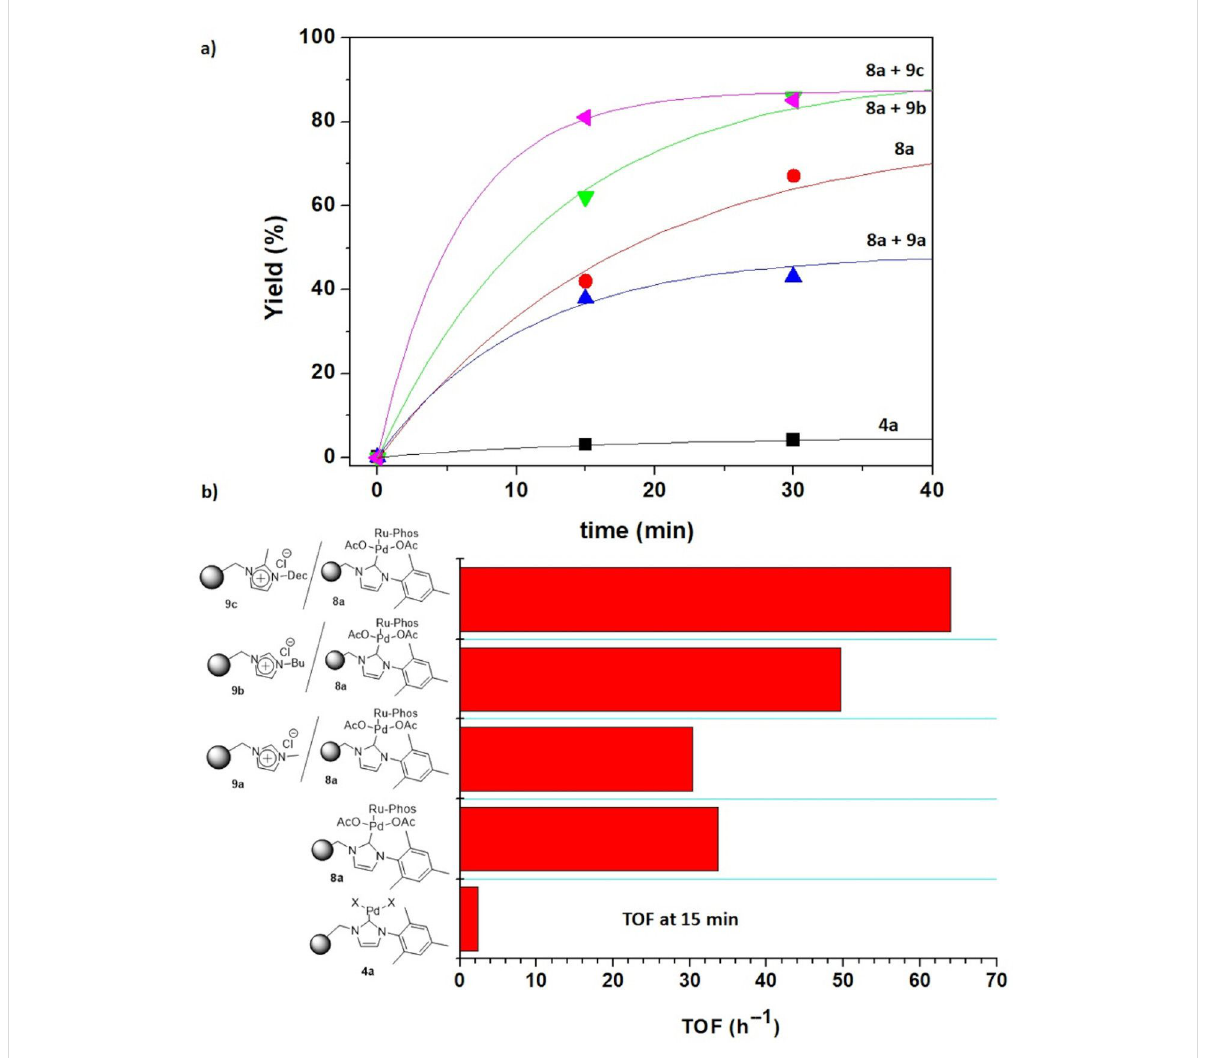
Figure 4: Negishi reaction between 5 and 6 catalyzed by 8a in the presence of SILLPs . a) Yield (%) vs time for different catalytic mixtures. b) TOF values obtained at 15 minutes. Conditions: 1 equiv methyl 4-bromobenzoate (0.25 mmol), 2 equiv benzylzinc bromide (0.5 mmol, 1 mL of a 0.5 M solution in THF), 5 mol % Pd catalyst (0.0125 mmol) in dry THF (1 mL). N 2 atmosphere. Yields calculated by GC and confirmed by 1 H